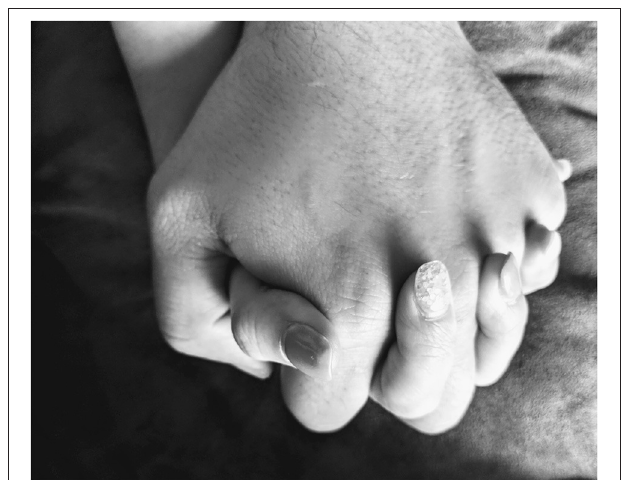
FIGURE 1 | Hand-in-Hand : Being a caregiver for a relative with a mental disorder means offering support, encouragement and guidance without expecting to receive anything in return. It is a team effort. It means offering support, encouragement, accompaniment and help to the other person, but also forgetting oneself and risking being dragged down when the parent relapses. It also means playing the role of parent to your parent and becoming a tool for their well-being. It tinges your emotions: it’s both satisfying and disappointing. But it does make you grow in any case.